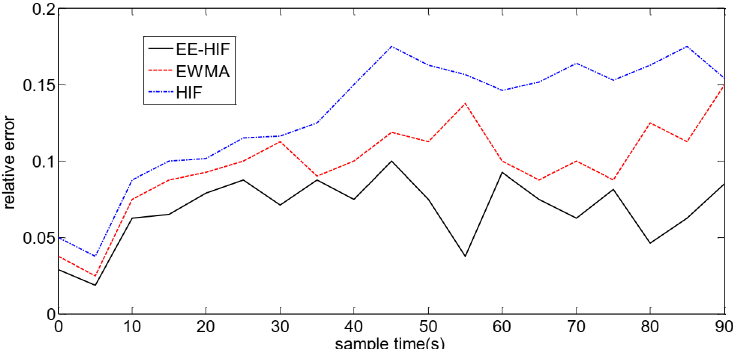
Figure 14. The SOC estimation error curve under an alternating current